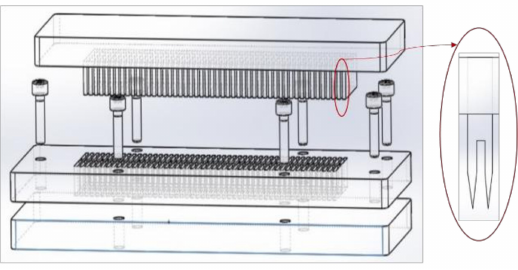
Figure 2. Architecture of the mold